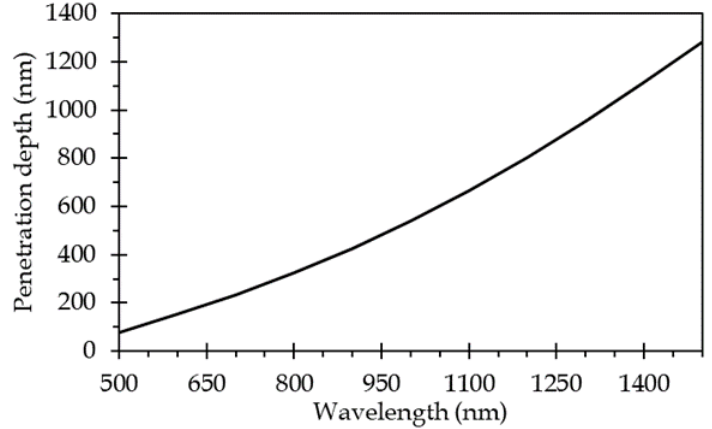
Figure 1. Penetration depth of plasmonic wave into the sensed medium (here water) versus wave- length of excitation light beam (here, the sensor surface is composed of 35 nm of gold).